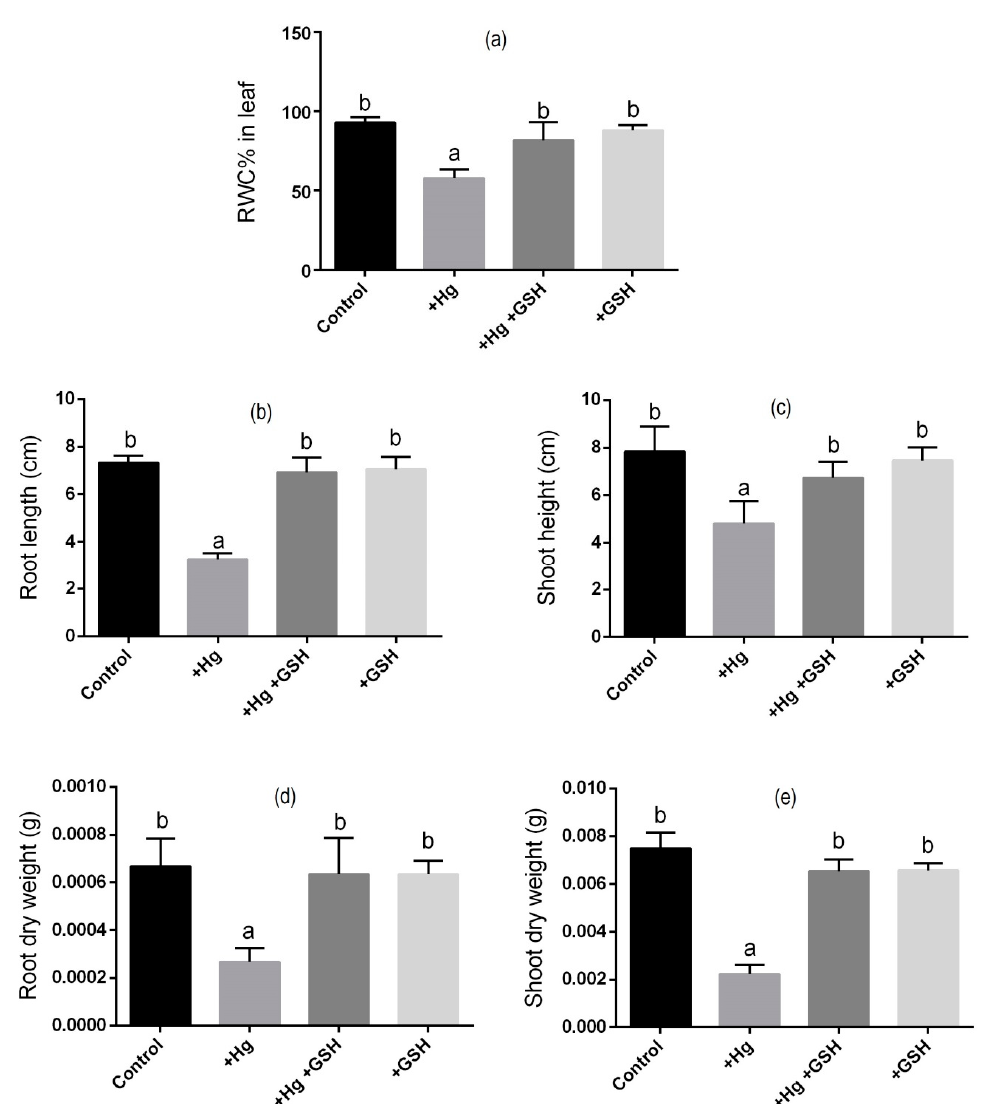
Figure 2. Changes in relative water content (RWC%) ( a ), root length ( b ), shoot height ( c ), root dry weight ( d ), and shoot dry weight ( e ) of alfalfa plants cultivated in di ff erent conditions of Hg and GSH: + Hg (40 µ M), + Hg + GSH (40 µ M Hg + 50 µ M GSH), and + GSH (50 µ M GSH). Data GSH: +Hg (40 μ M), +Hg+GSH (40 μ M Hg+50 μ M GSH), and +GSH (50 μ M GSH). Data represent